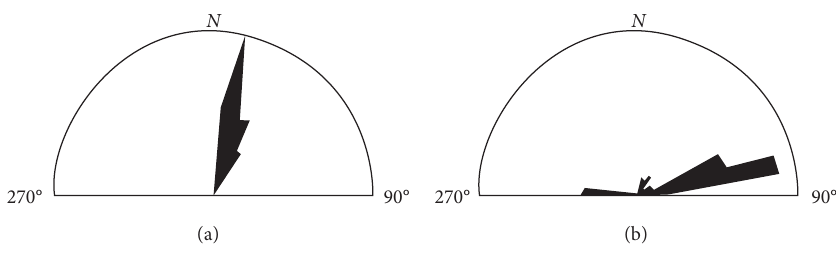
Figure 10: Rosette diagrams of fault strikes in the Qianqiu and Changcun mine. (a) Qianqiu mine. (b) Changcun mine.